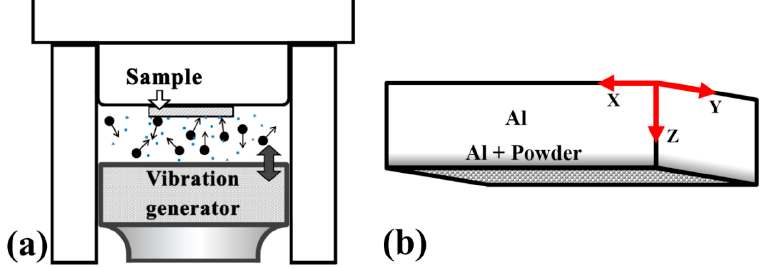
Figure 2. ( a ) Illustration of the setup and the finished sample of UMCA. The X , Y , and Z axes are defined in ( b ).